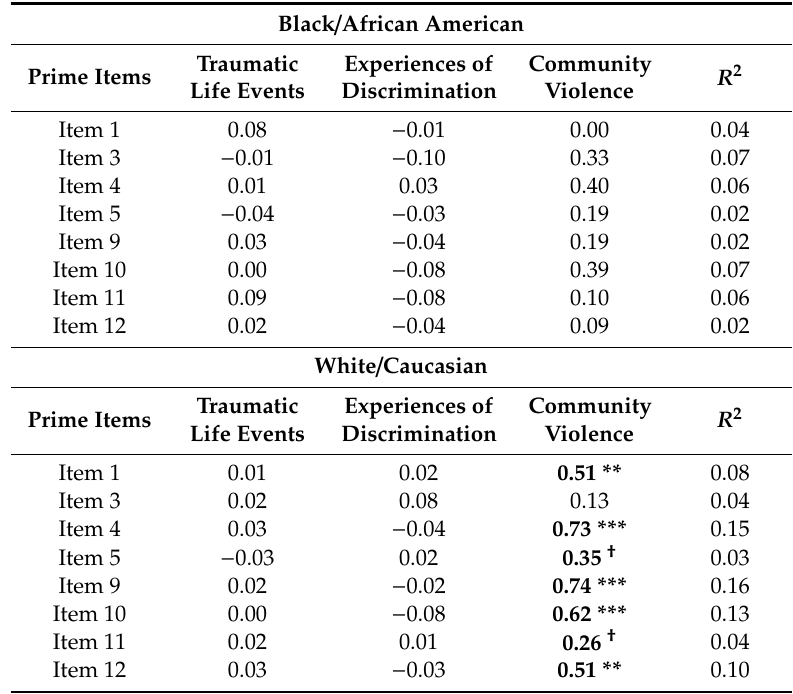
Table 5. Multivariate Linear Regression Models Predicting Good Fit Prime Screen Item